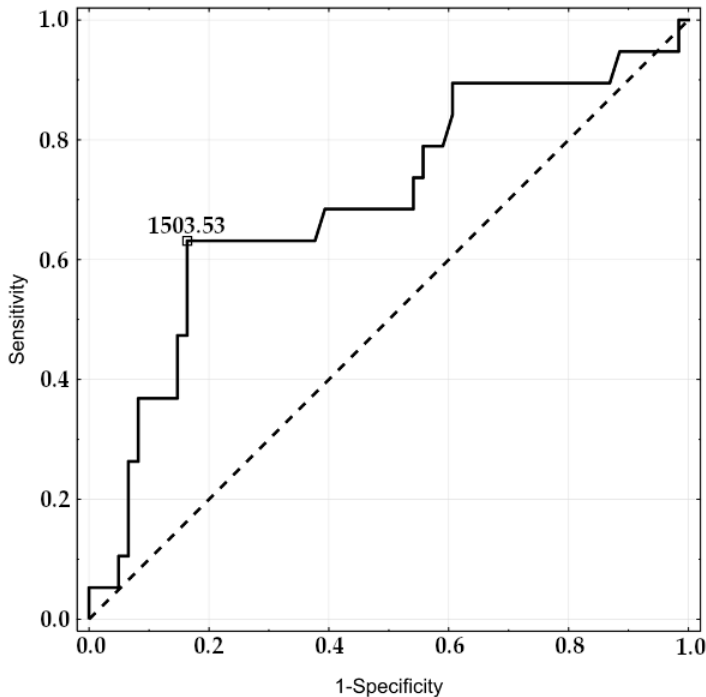
Figure 1. The receiver-operating characteristic curve of GDF-15 concentration as a predictor of no- reflow (AUC 0.698, 95% CI 0.552 – 0.843, p < 0.05).